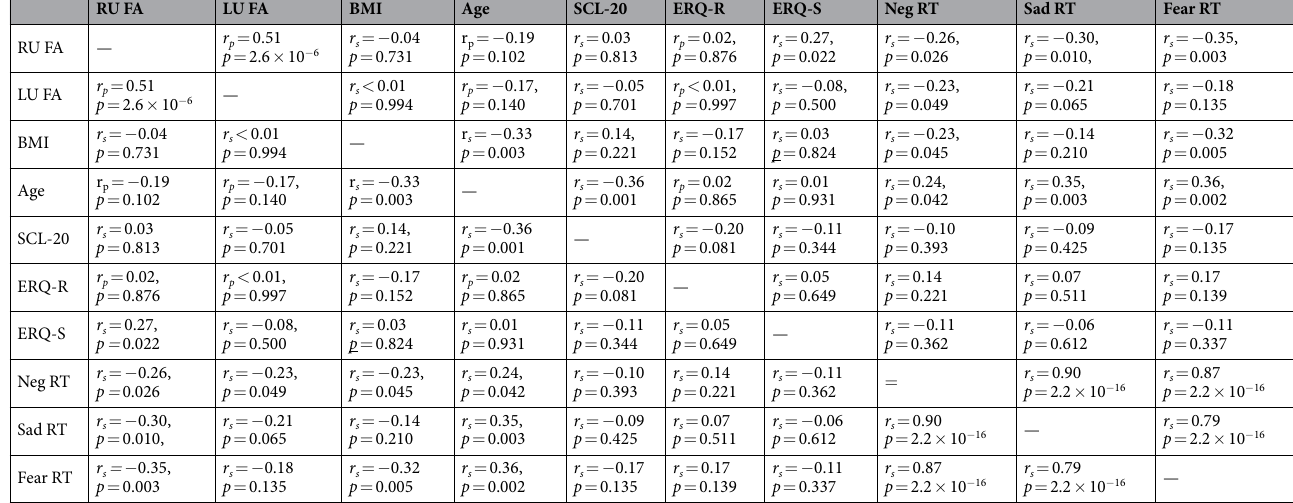
Table 2. Correlations between variables of interest. r s = Spearmans rho (one or more variables non-normally